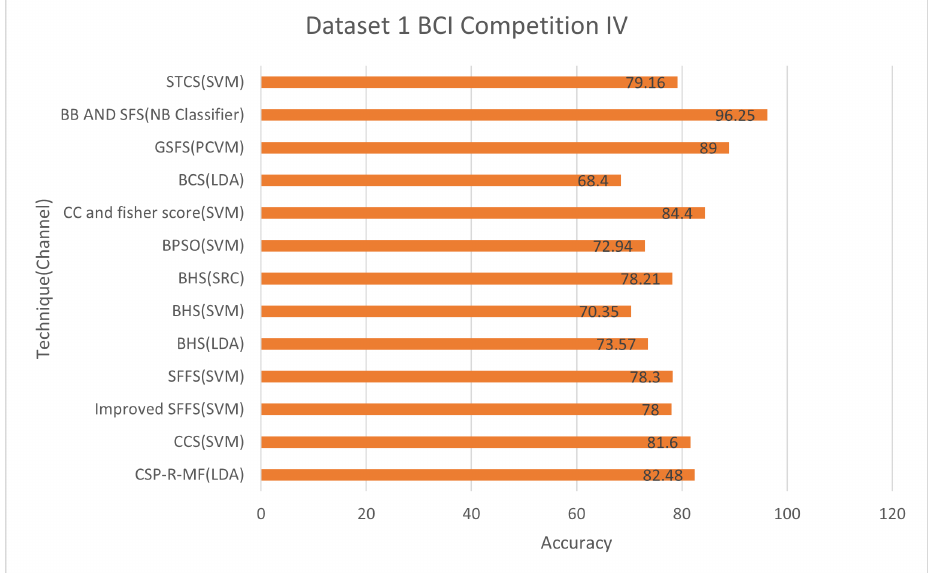
Figure 7. Accuracy by different techniques for Dataset I BCI Competition IV.